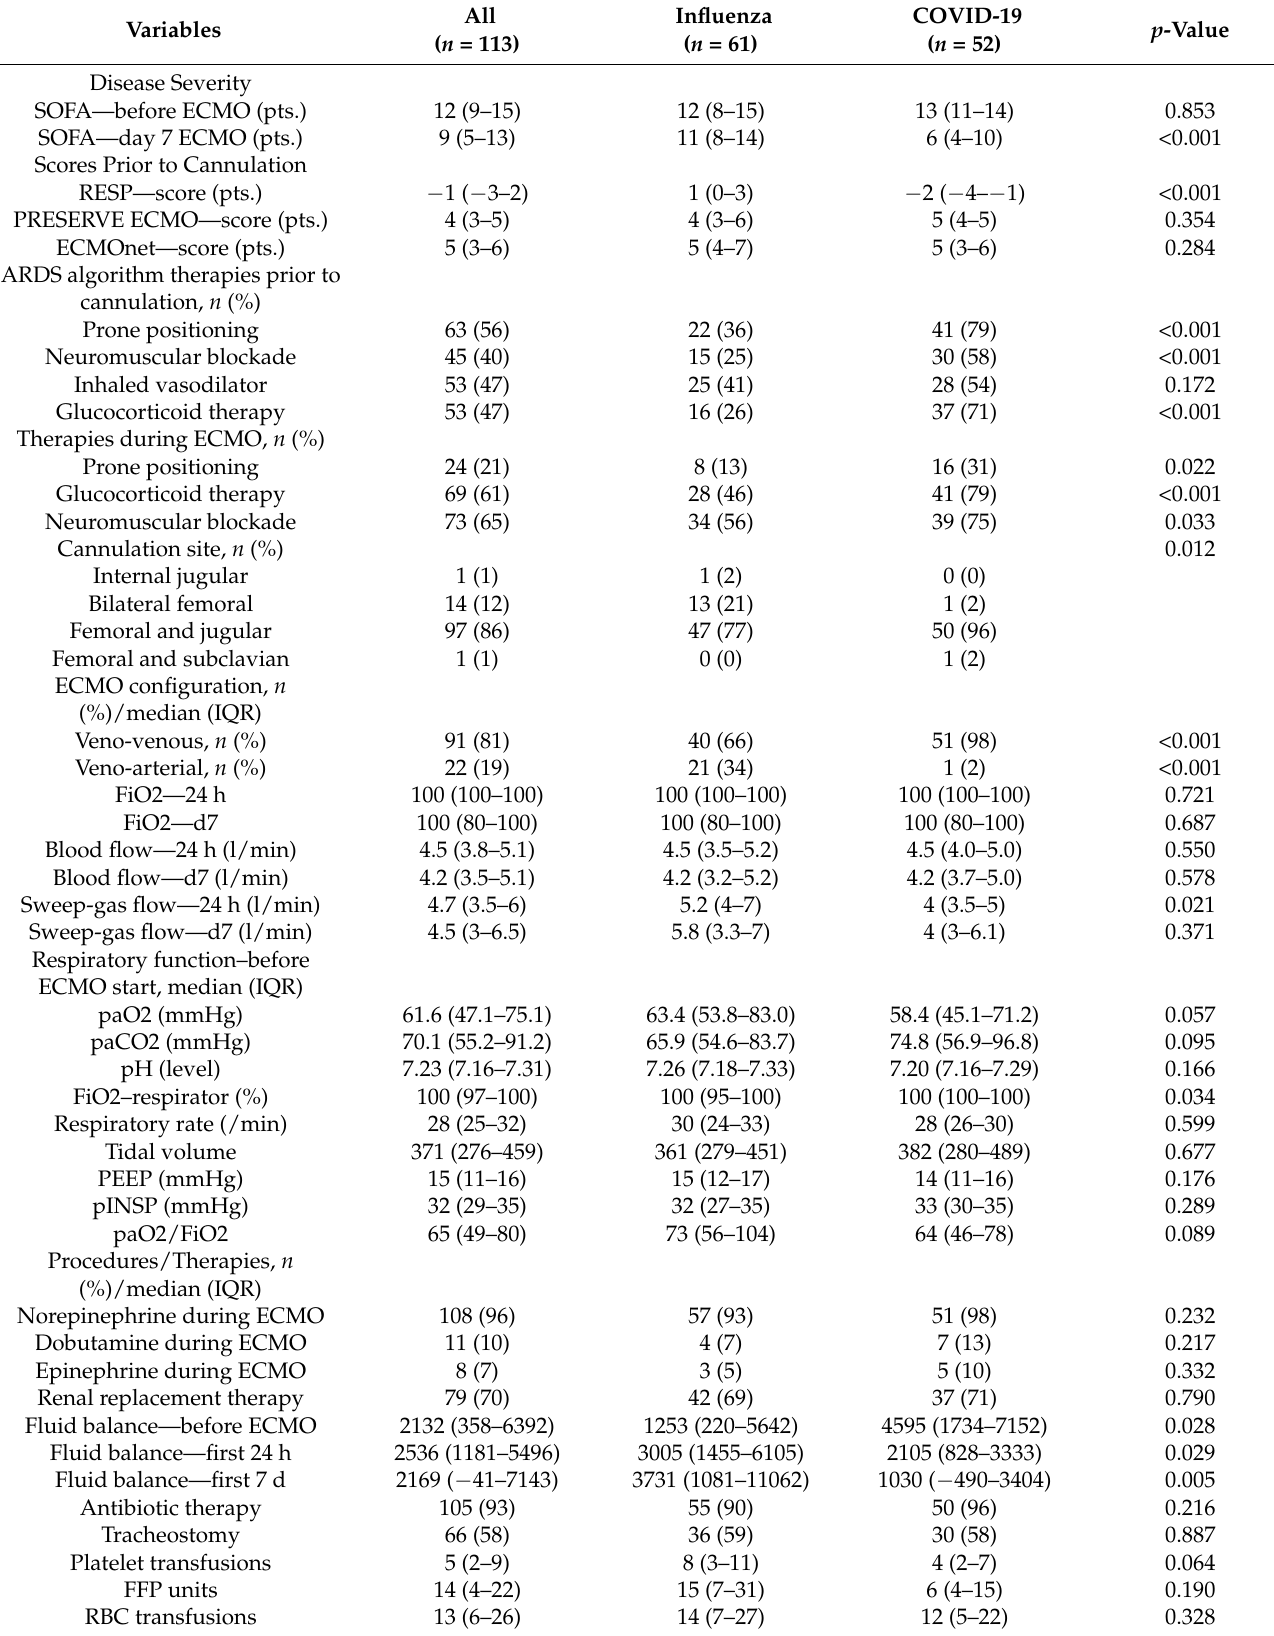
Table 2. vv/va-ECMO specific